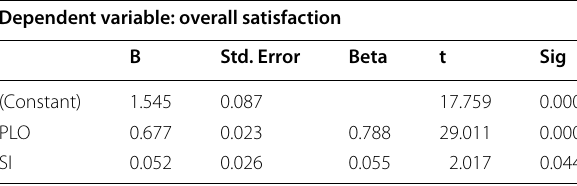
PLO Perceived learning outcome, SI student initiative